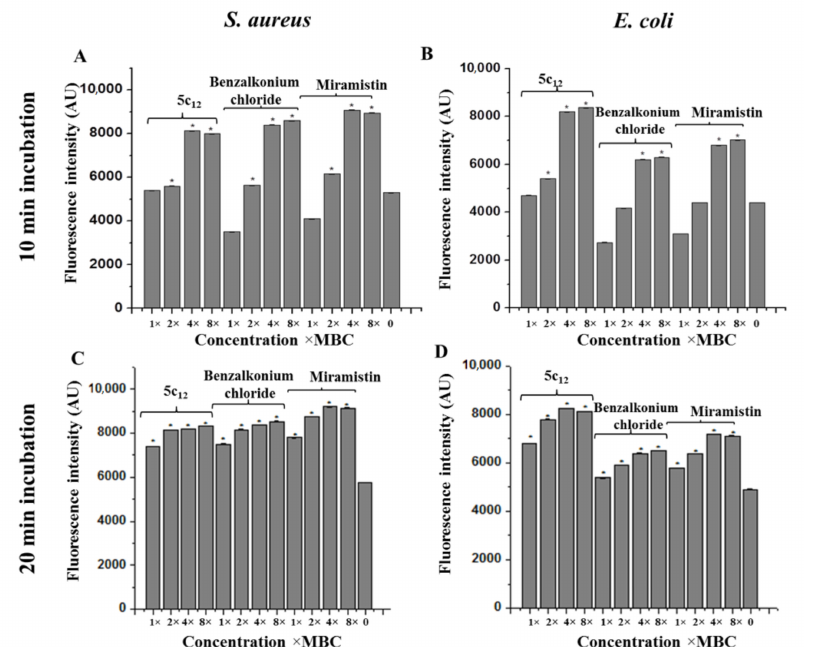
Figure 5. The e ff ect of 5c 12 on the electric potential of the bacterial membrane determined using a membrane-potential-sensitive cyanine dye DiSC 3 (5) (10 min treatment by 1–8 × MBC ( A , B ) and 20 min treatment by 1–8 × MBC ( C , D )). Asterisks denote a statistically significant di ff erence in comparison with untreated cells. * statistically significant di ff erence from the